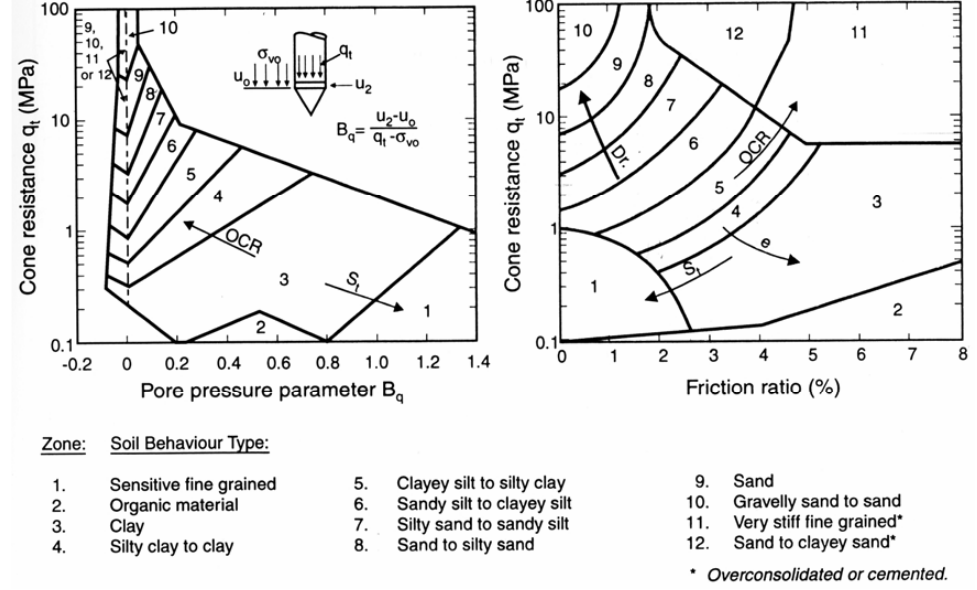
Fig. 3 – Proposed soil classification chart from piezocone data by Robertson et al.